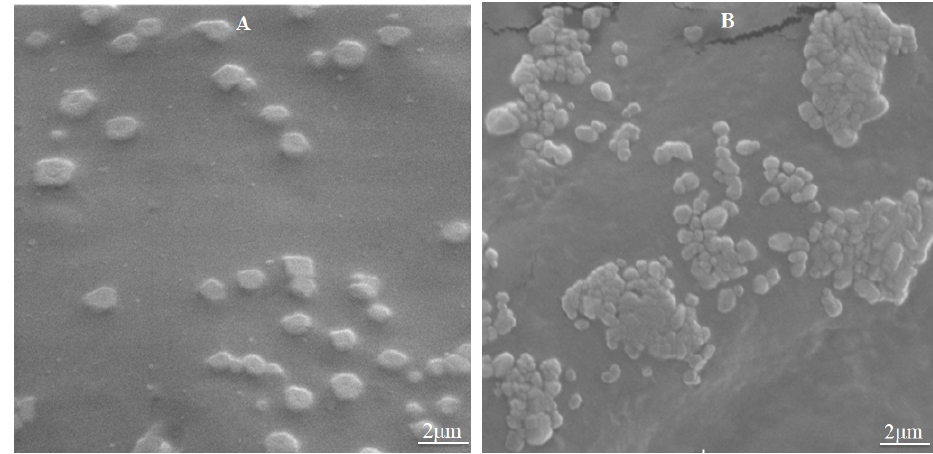
Figure 3. Scanning electron micrographs of HA – SH/CS nanoparticles after drying in carbon tape. ( A ) Negative nanoparticles (R = 0.10). ( B ) Positive nanoparticles (R = 0.50).